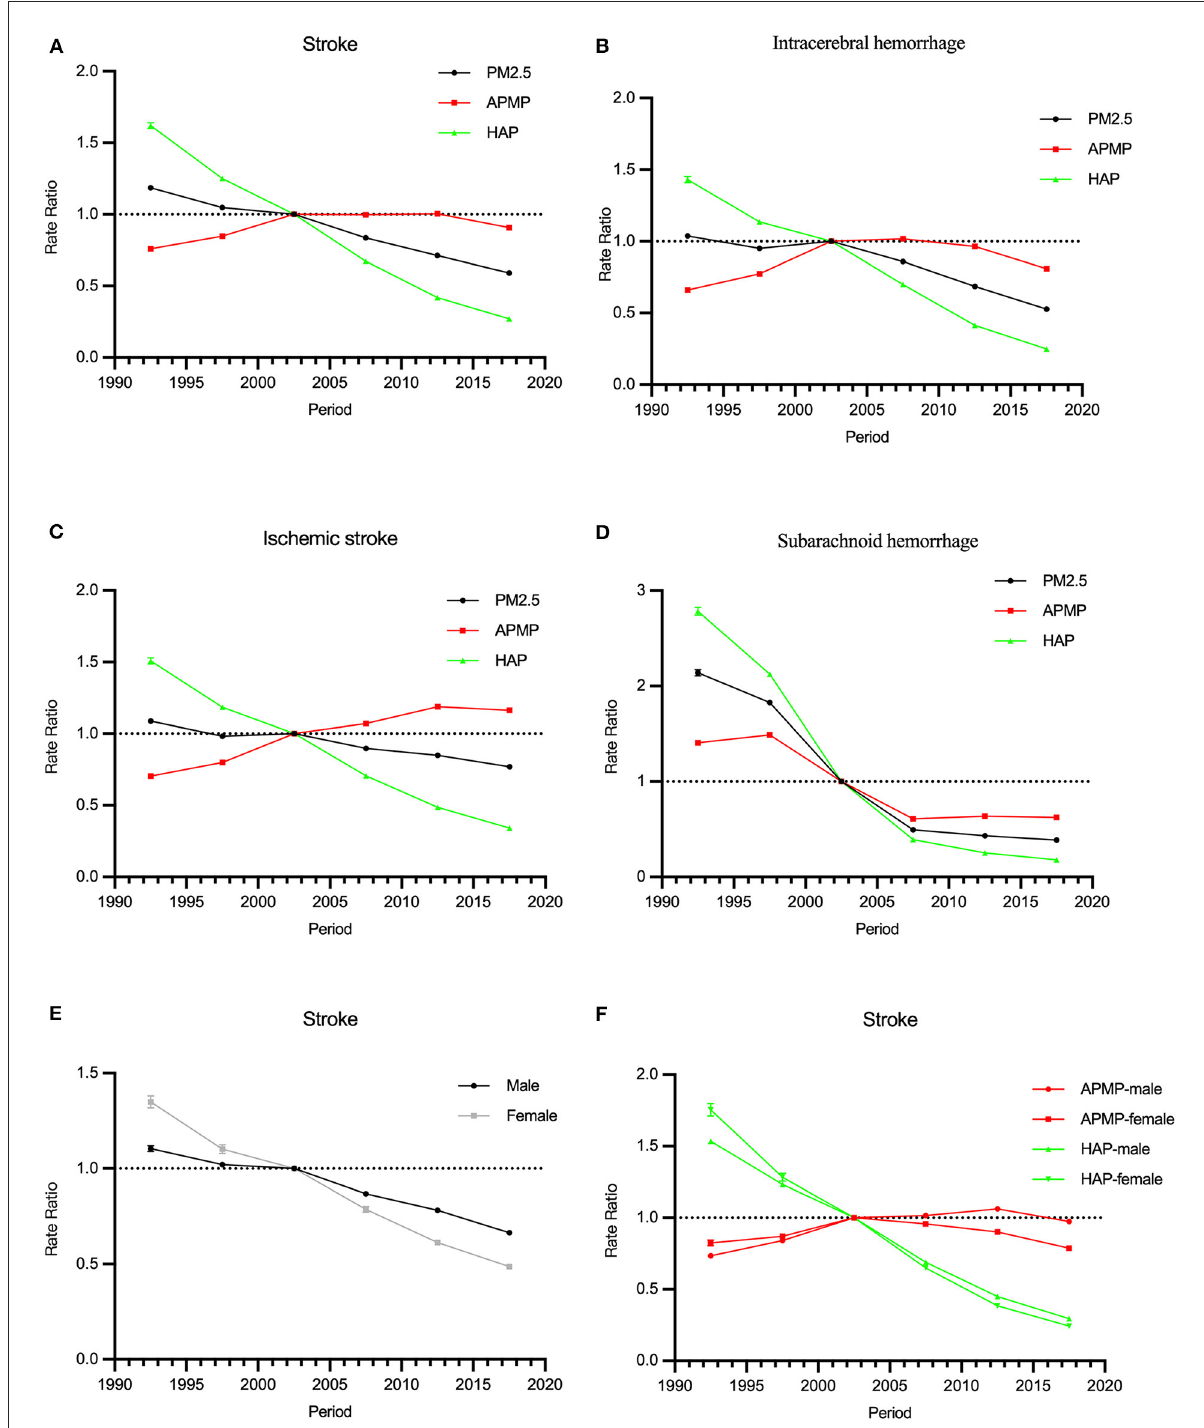
FIGURE3 The period RRs of the mortality rate of stroke attributable to PM2.5 exposure from 1990 to 2019. (A–D) The period RRs of stroke and subtypes for both sexes in PM2.5 exposure. (E) The period RRs of stroke by sex in PM2.5 exposure. (F) The period RRs of stroke by sex in ambient particulate matter pollution (APMP) and household air pollution